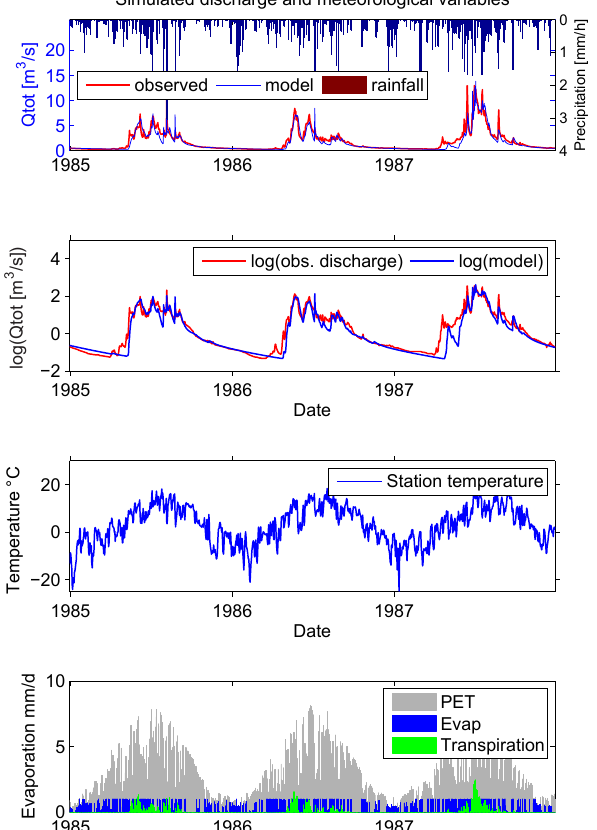
Figure 4. Observed and simulated hydro-meteorological time series of model state variables for the parameter set of Table 3.